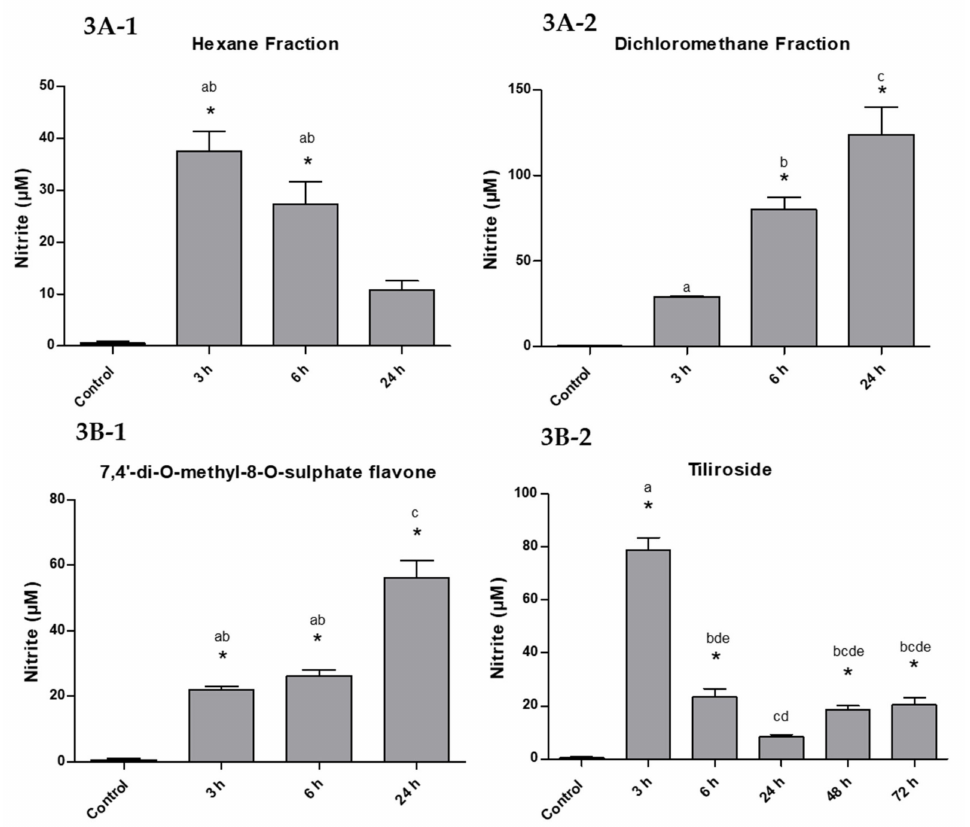
Figure 3. NO production in larvae exposed to LC 50 of the substances over time. (*) statistically significant in relation to the negative control. Bars with the same letter are not significantly di ff erent by Tukey test,